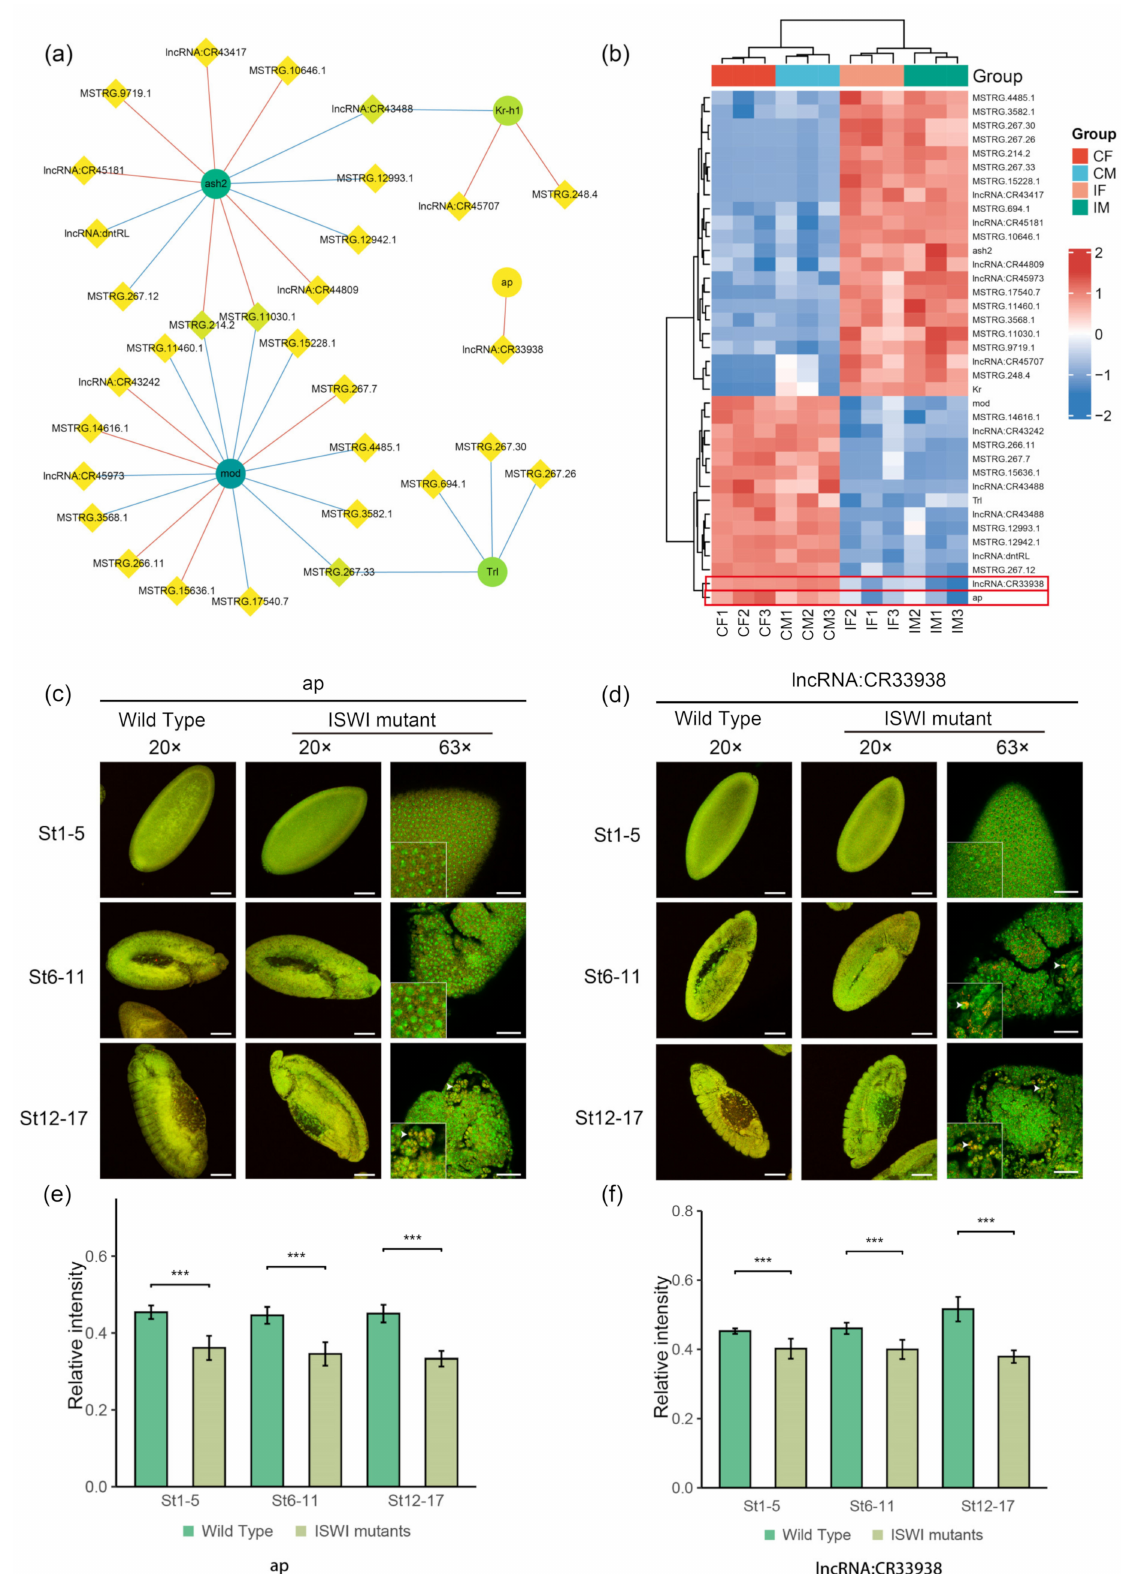
Figure 7. A possible interactor of DE-lncRNAs associated with trans-acting dosage-sensitive factors. ( a ) Network diagram of trans-acting dosage-sensitive factors and their co-expressed lncRNAs. The diamond nodes represent lncRNAs, and the circle nodes represent mRNAs. The darker the color of node, the higher the degree of connection (the more co-expressed interactions). The red edge